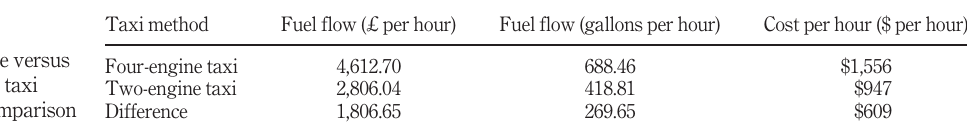
Table 4. Four-engine